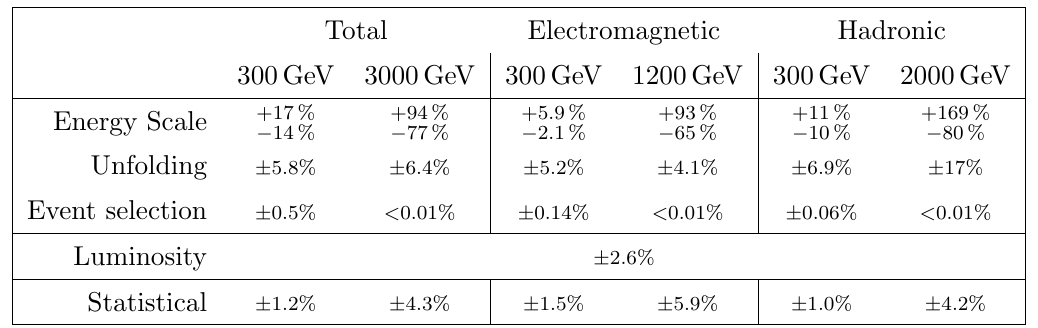
Table 1 . Uncertainties on the di(cid:11)erential cross sections at a few selected values of the total, electromagnetic, and hadronic